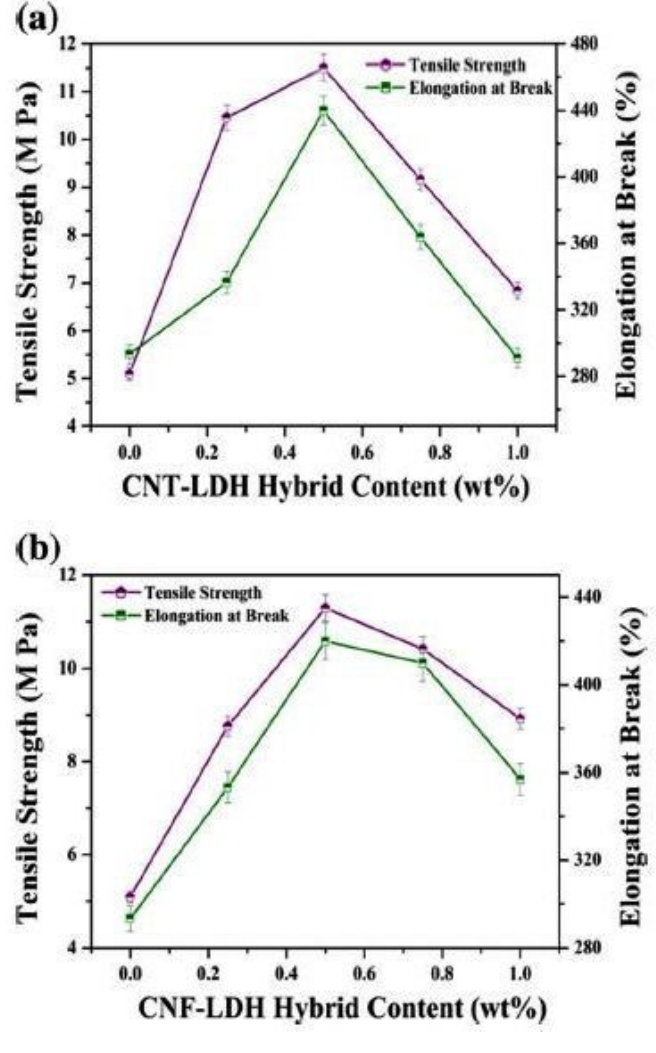
Figure 14. ( a ) Variation of tensile strength and elongation at break of TPU/NBR (TN) nanocomposites with Zn-LDH/surfactant modified CNT-layered double hydroxide (SFCNT-LDH) hybrid content; ( b ) Variation of tensile strength and elongation at break of TN nanocomposites with SFCNFLDH hybrid content. Reproduced with permission from [112], Copyright Springer, 2016.